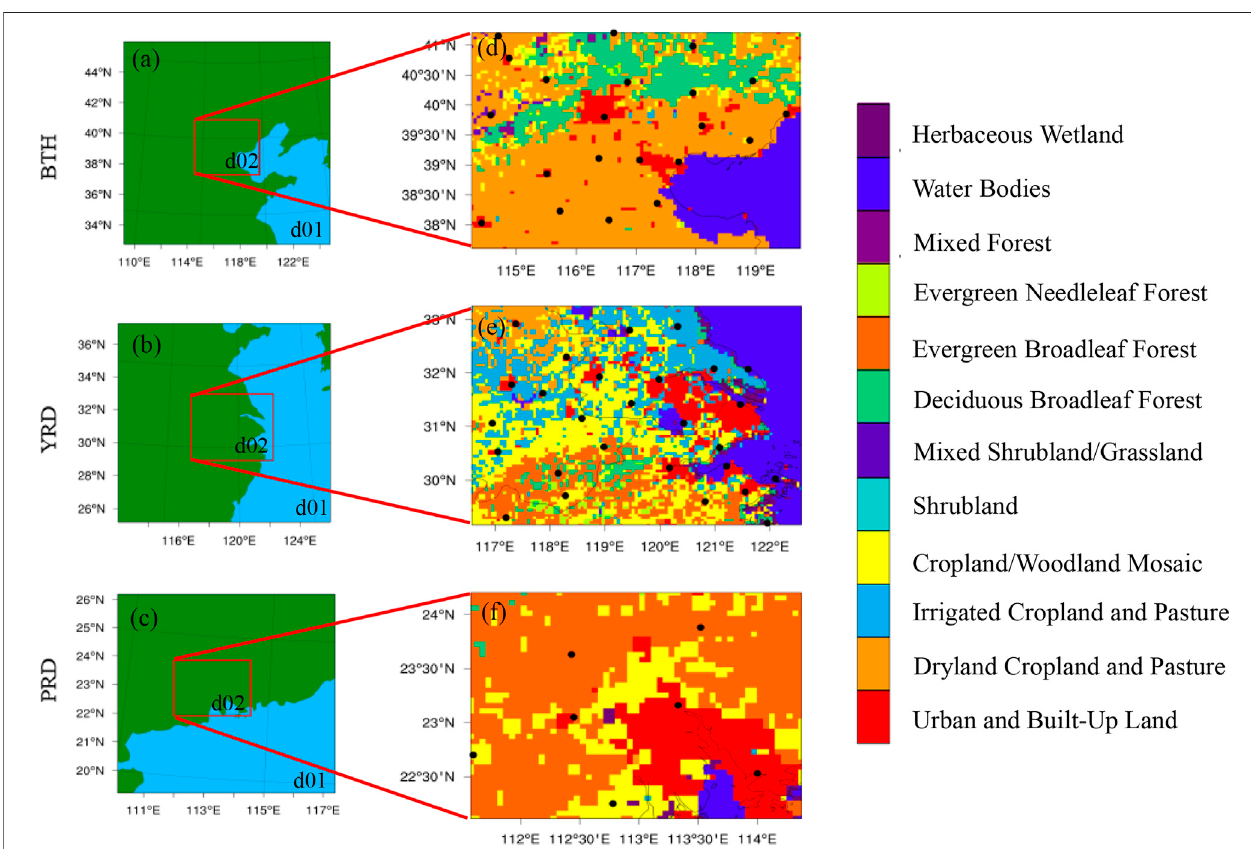
FIGURE 1 | Double-nested model domains used in the study, with D01 as the outer domain and d02 being the innermost domain for (A) Beijing-Tianjin-Hebei region (BTH) (B) Yangtze River Delta (YRD) and (C) Peral River Delta (PRD) respectively. Land-use and land cover categories over BTH, YRD and PRD are shown in (D – F) . The black spots in (D – F) denote the meteorological observation stations over the three urban